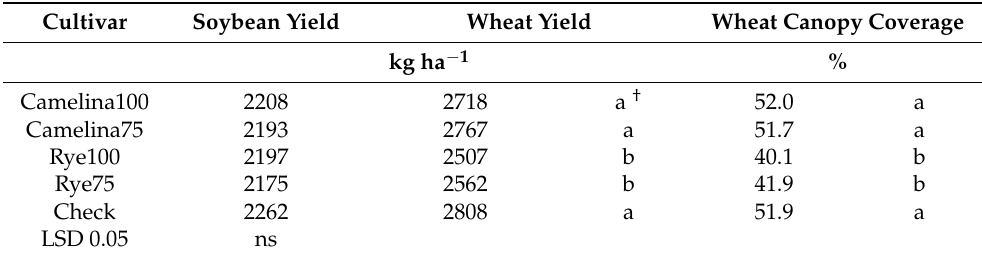
Table 9. Mean soybean (2016–2017) and wheat yield (2017–2018) and wheat canopy coverage for five cover crops across four environments in Fargo, ND, USA. Cultivar Soybean Yield Wheat Yield Wheat Canopy Coverage kg ha − 1 % Camelina100 2208